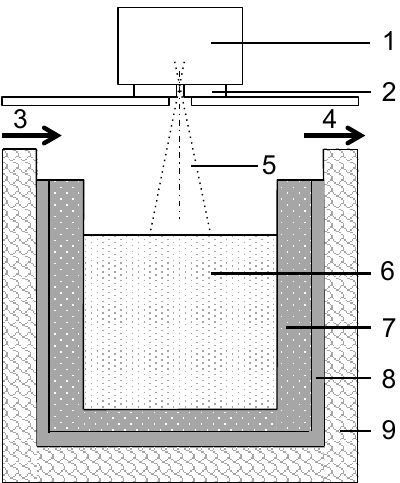
Figure 1. Scheme of the experimental setup for the synthesis of copper